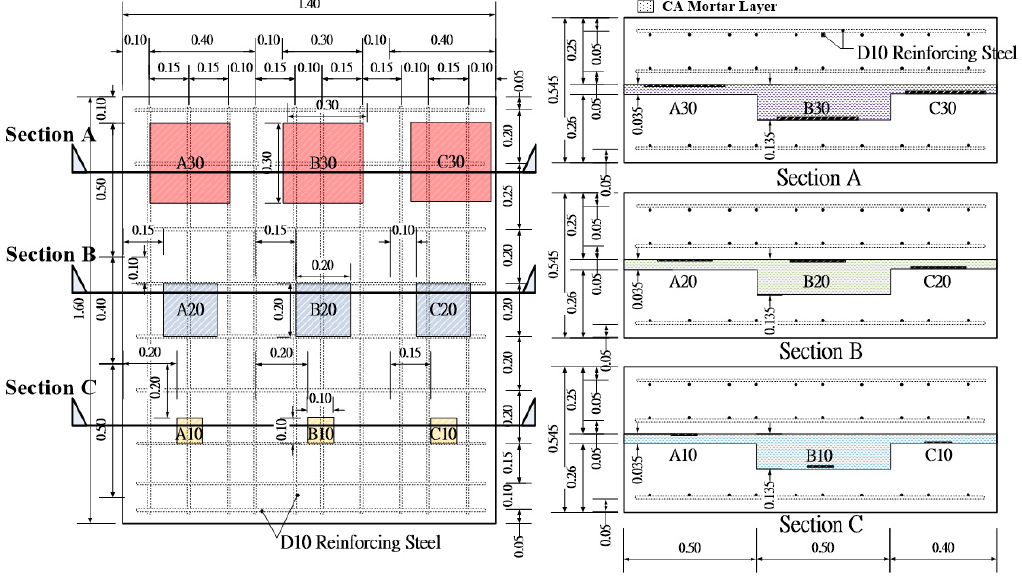
Figure 4. The layout of the specimen design.